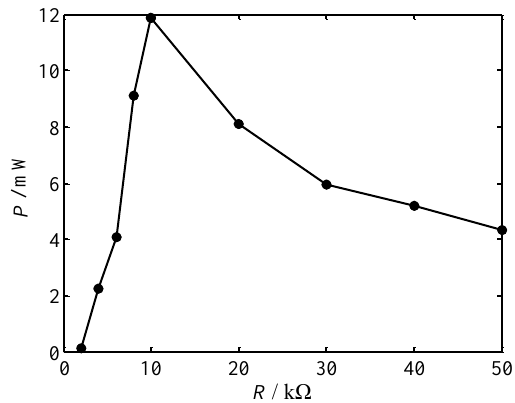
Figure 14. The total power varies with the load resistance. By comparing the output voltage and output power under continuous excitation and transient excitation, it can be seen that the output voltage under transient excitation was instantaneous, while the output voltage under continuous excitation changed con- tinuously with time. The output power changed slightly with the load resistance under the transient excitation, while the output power changed greatly with the load under the continuous excitation. The reason is that the energy under transient excitation is limited, and when the excitation amplitude is appropriate, the maximum output energy can be reached. In the case of continuous excitation, the output of energy is continuous. Under different loads, the energy loss is also different, and the power obtained is also different. Therefore, the research in this paper is applicable to power generation under any continuous excitation and transient excitation and has a certain reference value. 4. Conclusions In this paper, a micro-power generator based on two piezoelectric MFC films is proposed. The design process of this kind of piezoelectric generator is given. Based on LabVIEW platform and NI DAQ card, the output voltage acquisition system of the gen- erator is built. Experimental results show that the maximum output power can reach 6.2 mW under transient excitation. Under continuous excitation, the output voltage and power of the two piezoelectric MFC films of the generator have the same variation law. The maximum total power occurs when the load resistance is 10 kΩ, and the excitation frequency is 26 Hz, with a maximum of 11.9 mW. The research results lay a foundation for the application of micro-power piezoelectric generators. Author Contributions: Conceptualization, C.L.; Investigation, Y.M.; Validation, J.W.; Writ- ing—original draft, C.L.; Writing—review and editing, X.F. All authors have read and agreed to the published version of the manuscript. Funding: This research was funded by National Key Research and Development Program of China (No.2018YFC0309100) , National Natural Science Foundation of China (No.51905228), China Postdoctoral Science Foundation (No. 2018M640515). Conflicts of Interest: The authors declare no conflict of interest. References 1.